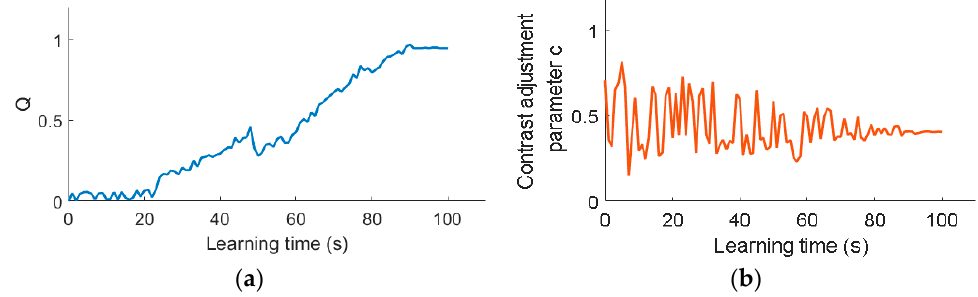
Figure 8. Reinforcement Learning process of related parameters. ( a ) The curve of Q value; ( b ) The curve of contrast adjustment parameter c.